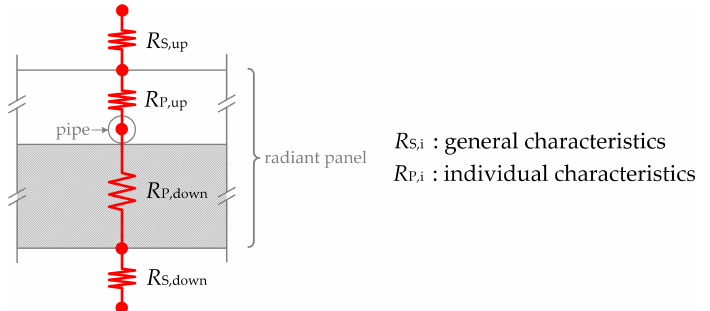
Figure 2. Heat transfer resistances involved in the heat transfer from the hot water to the room around the radiant panel, and classification of their